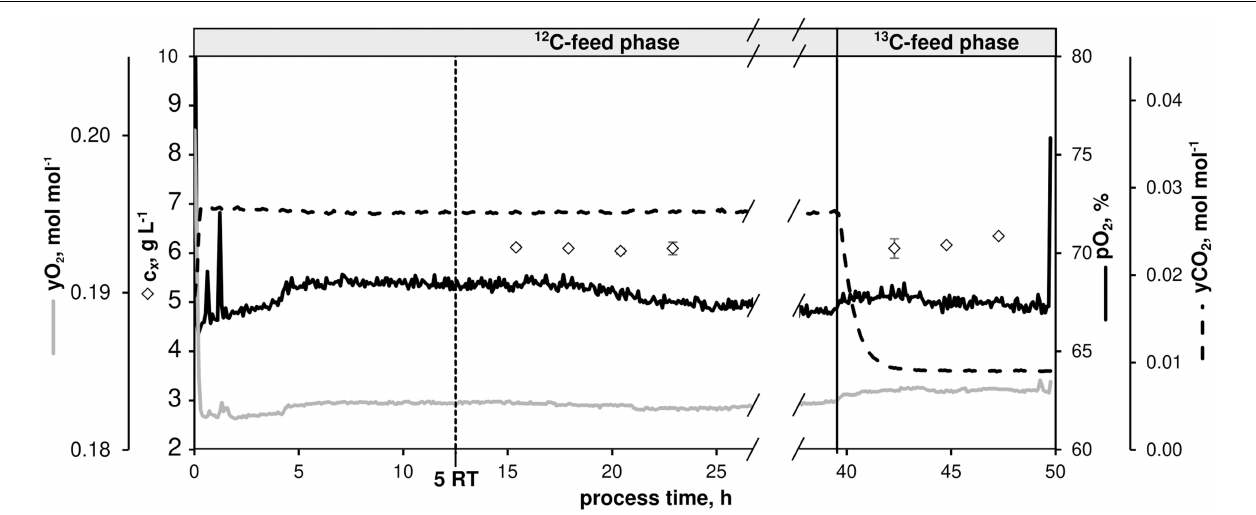
FIGURE 7 | Process parameters of the continuous 13 C-labeling experiment with C. glutamicum WT: dissolved oxygen ( pO 2 ), off-gas molar oxygen ( y O2 ) and carbon dioxide ( y CO2 ), biomass concentration (black diamonds). The dilution rate ( D ) was set to 0.4 h - 1 . Sampling in the 12 C-phase was initiated after five residence times (RT, 12.5 h). After 39.5 h, feed was switched to isotopic CGXII medium containing a 12 g D -glucose L - 1 mixture [67% (U- 13 C)- D -glucose and 33% (1- 13 C)- D -glucose]. Residual process parameters were kept constant. Depicted standard deviations of biomass measurements were calculated from three technical replicates per sample.